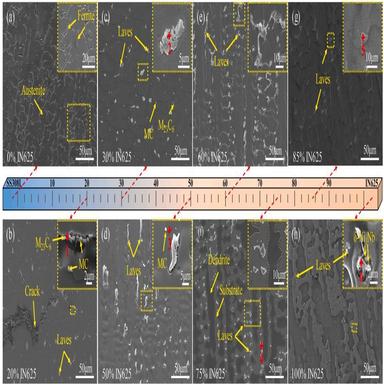
SEM images of the FGM from 100 wt% SS308L (a) to 100 wt% IN625 (h), with weight fractions of IN625 marked.